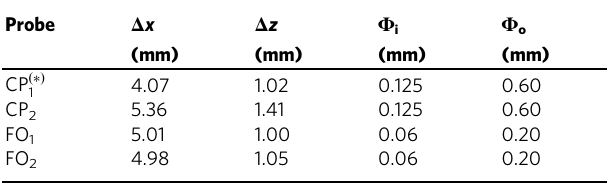
The probe marked with (*) was used for the results presented in the main text, the other probes are compared in Supplementary Fig.